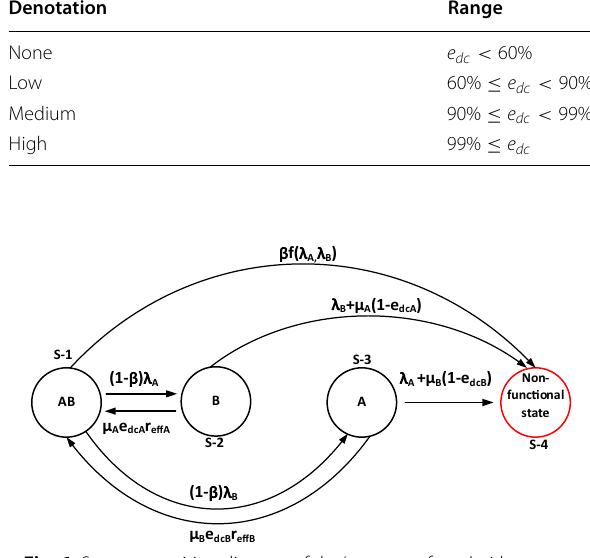
Fig. 6 System transition diagram of the ‘one-out-of-two’ with imperfect repairs and CCF based on Markov process